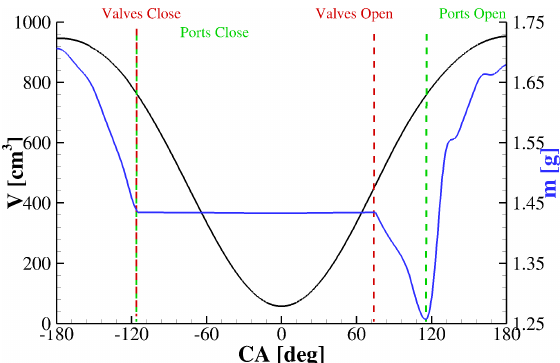
Figure 8. In-chamber volume and mass as a function of